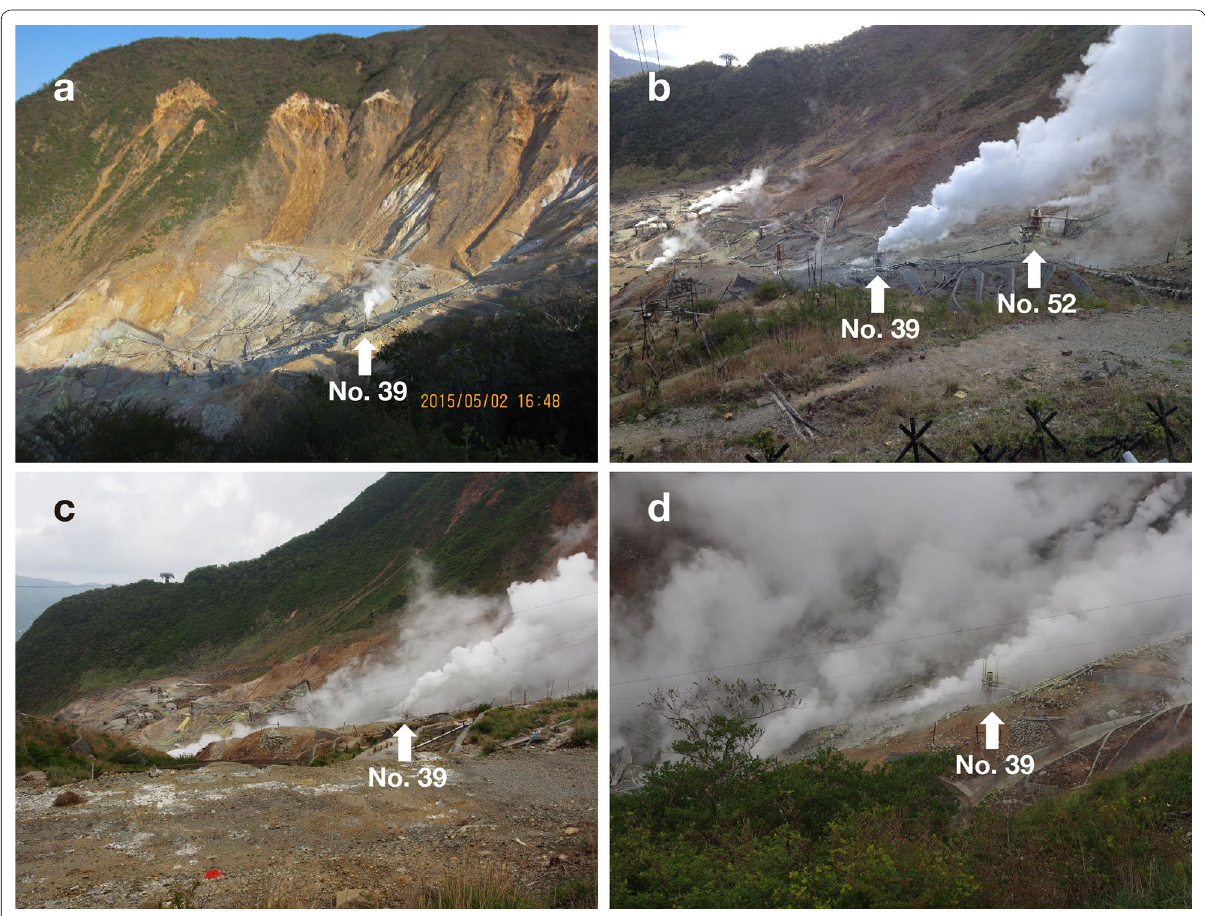
Fig. 8 Development of steaming activity at Owakudani before the 2015 Hakone eruption. See Fig. 2 for the shooting locations. a Slightly intensified steaming from the no. 39 SPW (16:48, May 2, 2015; from location c . b Blowout of no. 39 (7:36, May 3, 2015; from near REGMOS). c Ground steaming around the no. 39 SPW (10:35, May 18, 2015; from near REGMOS). d Ground steaming around the no. 39 SPW (9:04, June 20, 2015; from near HSRI camera). Note that no. 39 SPW is not steaming in late June. All photos were taken by